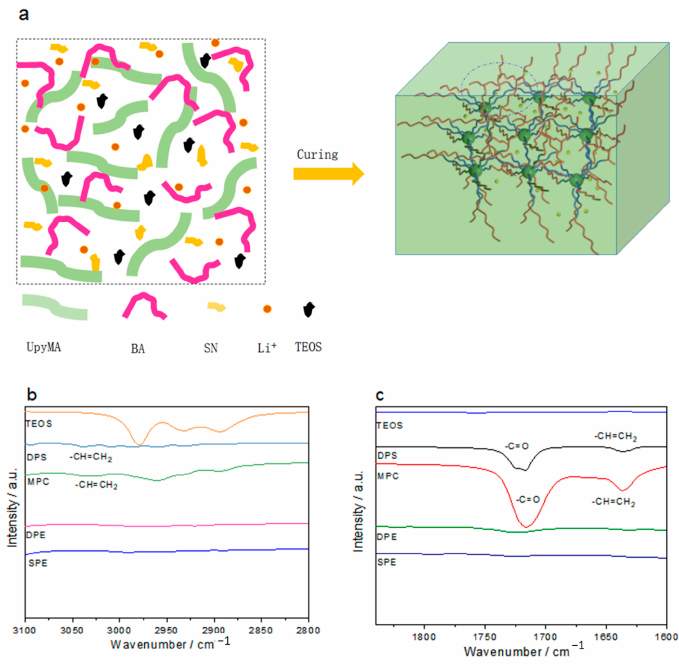
Figure 1. ( a ) Preparation route of a double-network PE. ( b , c ) FTIR characterization of related monomers and PEs.